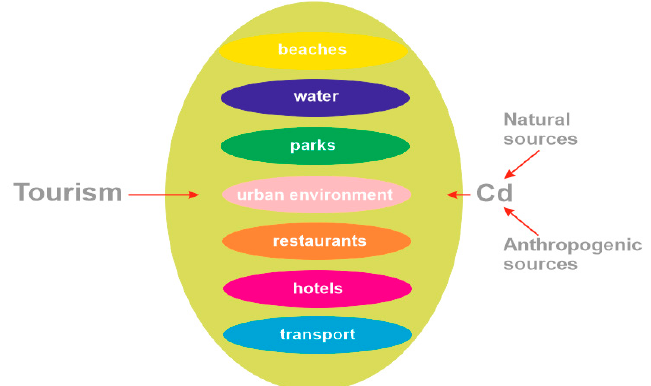
Figure 6. Schematic representation of the cadmium–tourism relationships through the components of the tourism environment (according to the literature reviewed here).